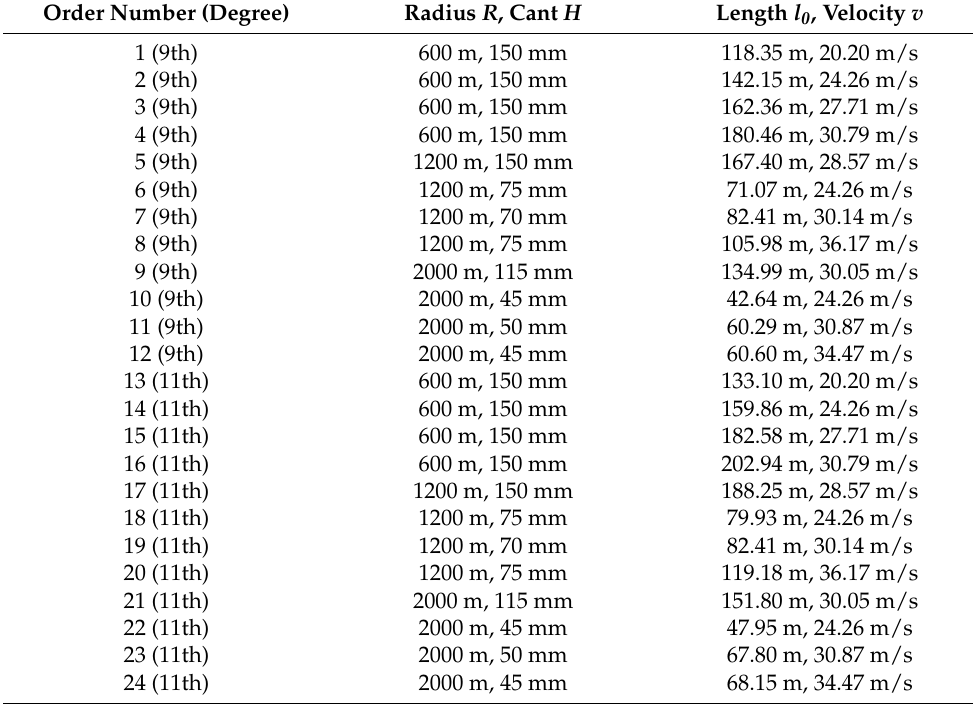
Table 1. Assumed parameters for 9th and 11th